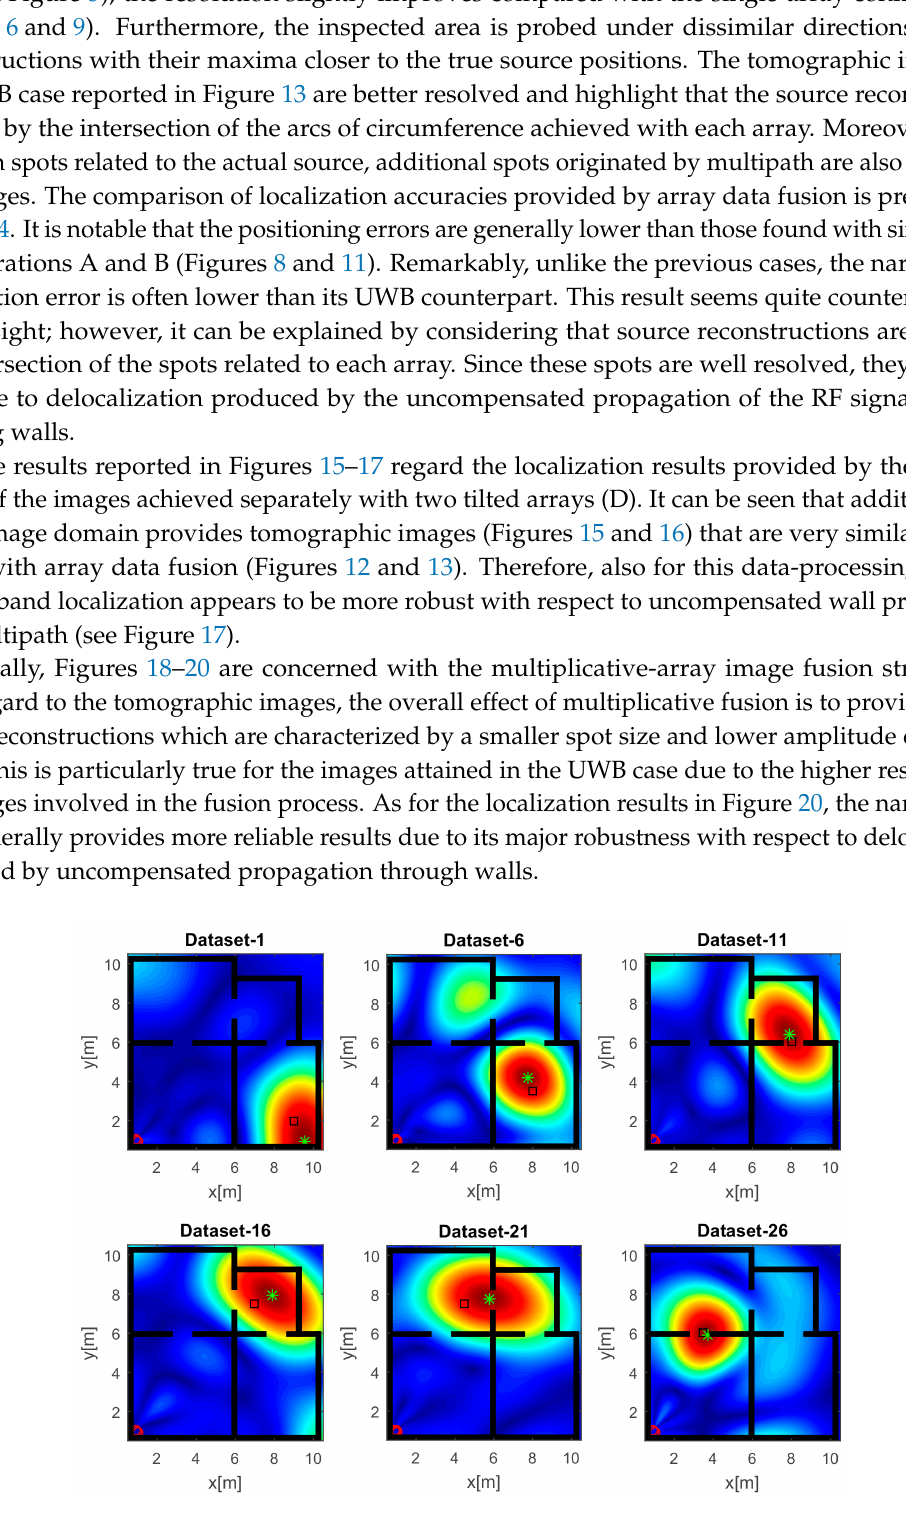
Figure 9. Tomographic images of a narrow band source achieved with the tilted array (B). Array (red circles); true source position (black square); estimated source position (green asterisk). Color scale is [0,